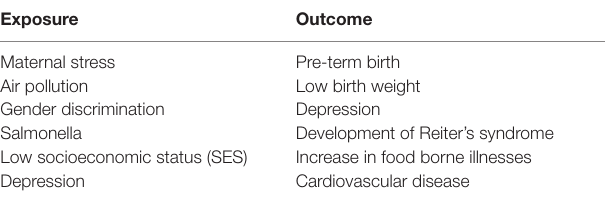
tABLe 1 | example of student exposures and